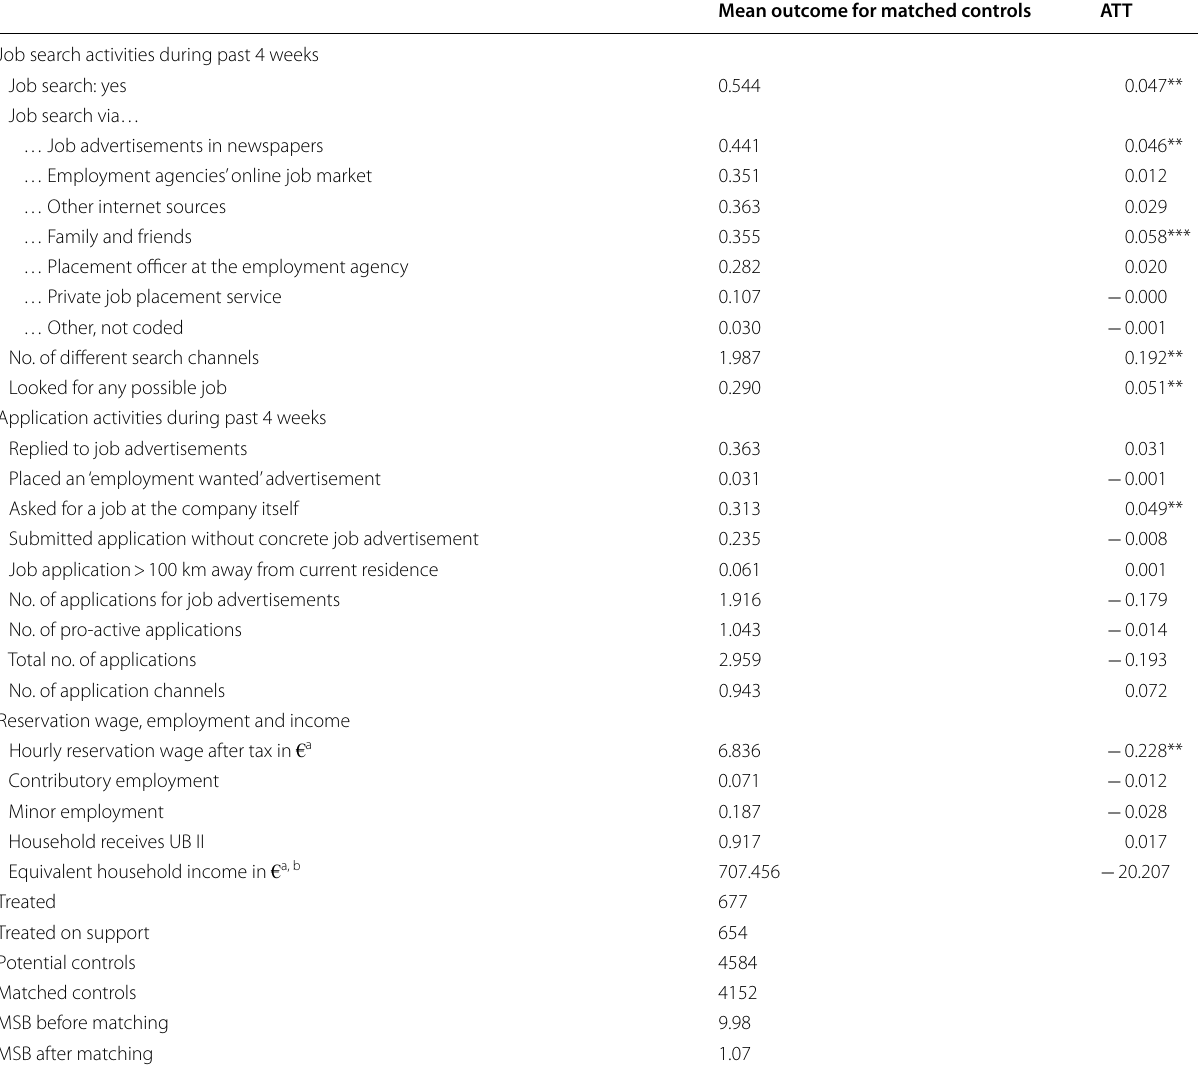
Table 4 ATT of receiving a One‑Euro‑Job announcement and mean outcomes for matched controls. Source: